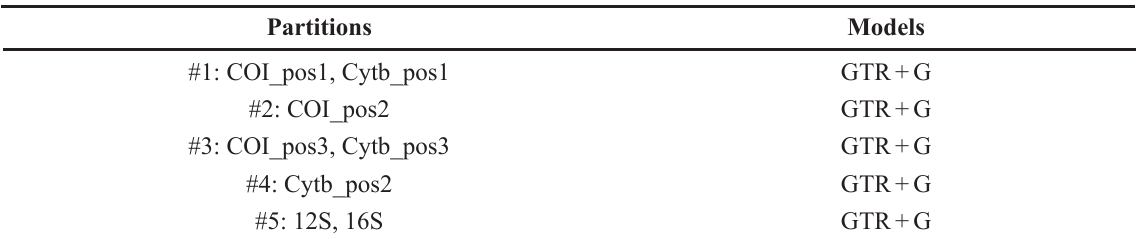
Table 2. Results of PartitionFinder analyses, based on the